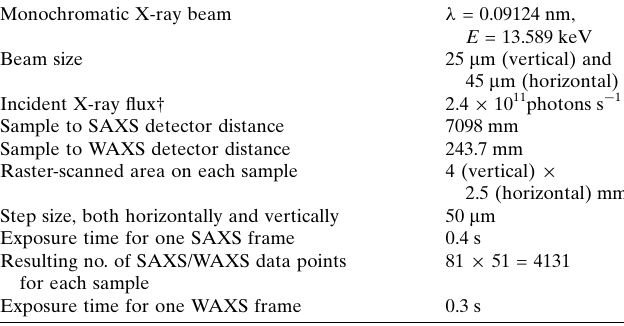
Table 1 Experimental details for the SAXS/WAXS